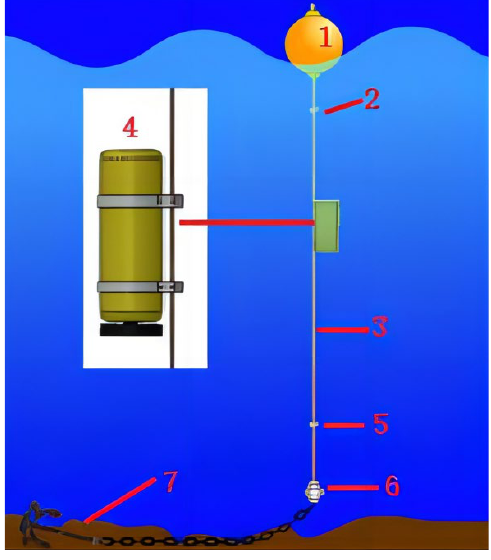
Figure 3. Profile AUV system .